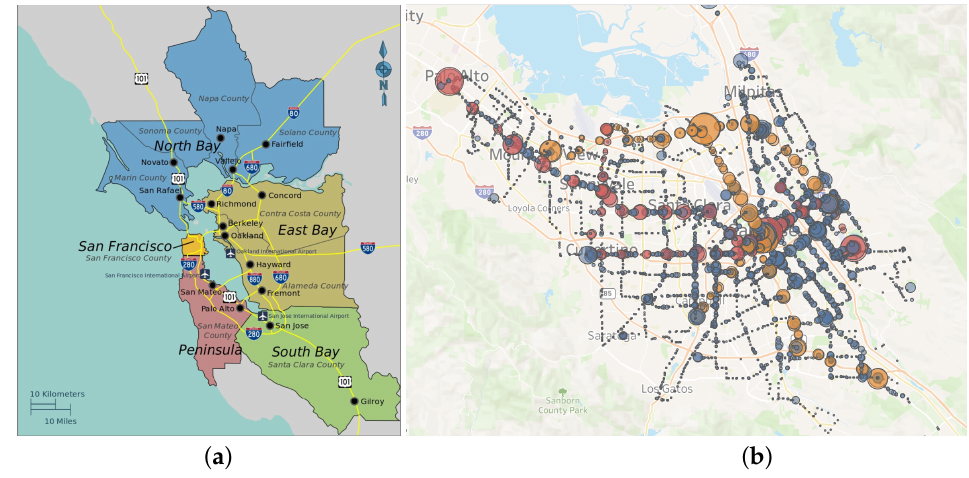
Figure 1. ( a ) The Bay Area and its nine counties are shown (Mapping the Bay: https://exhibits.lib.b erkeley.edu/spotlight/mapthebay/feature/sf-bay-area, accessed on 14 April 2023), ( b ) The location of transit stops weighted based on the average ridership in Santa Clara County are shown—blue are bus stops, orange are light rail stations, and red are rapid bus stops (VTA transit stops ridership: https://data.vta.org/pages/ridership-by-stop, accessed on 14 April